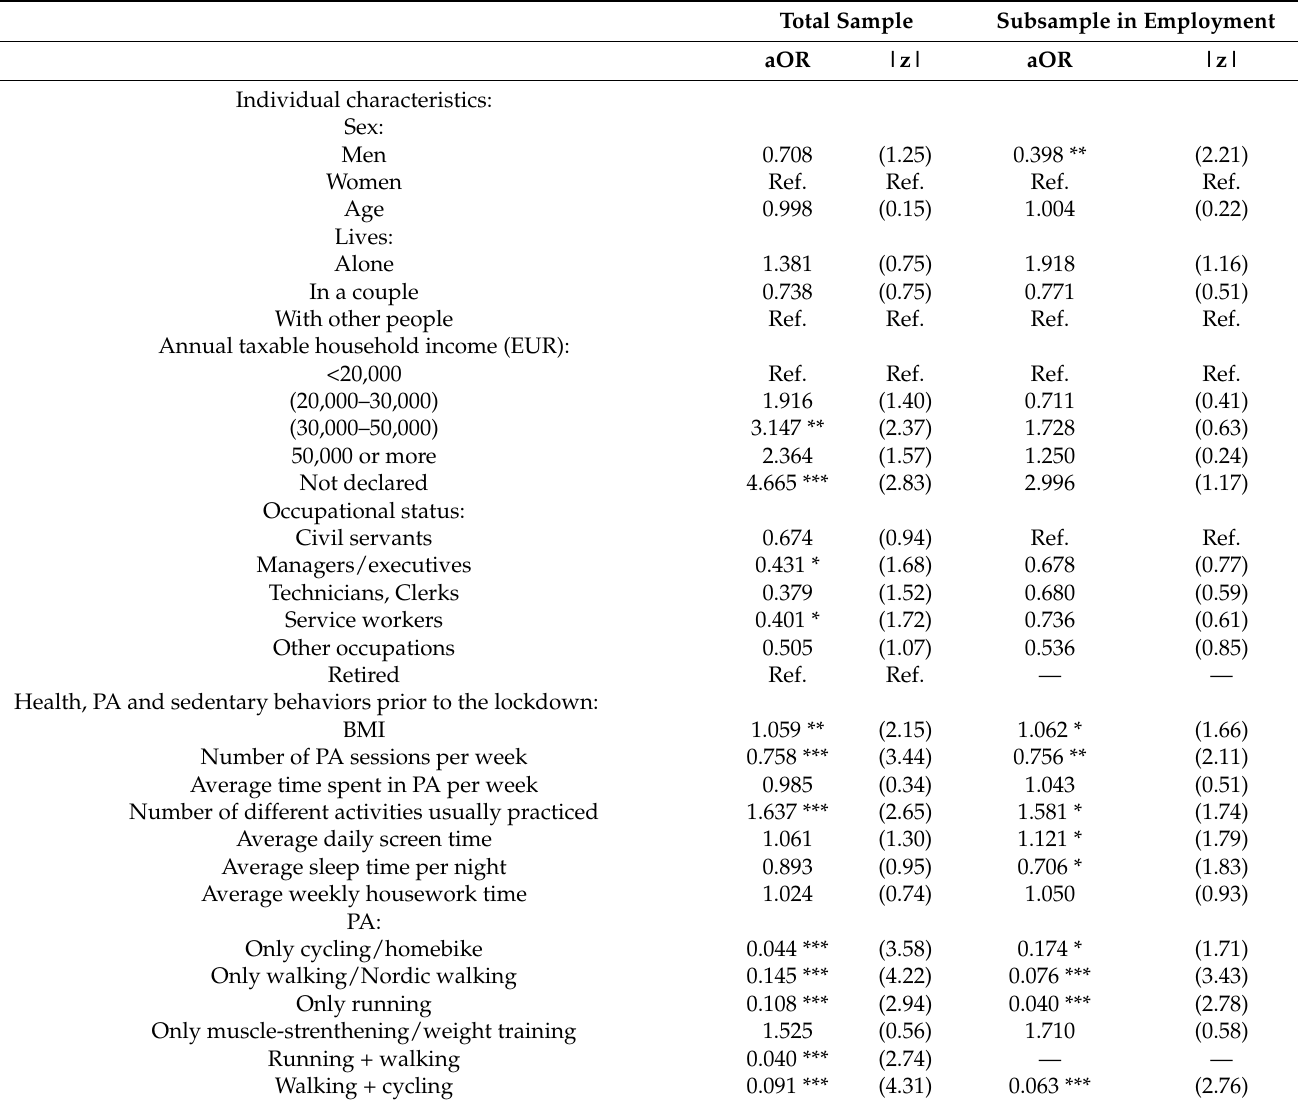
Table 2. The results of the multivariate logistic regressions explaining difficulties in practicing PA during the health crisis. Total Sample Subsample in